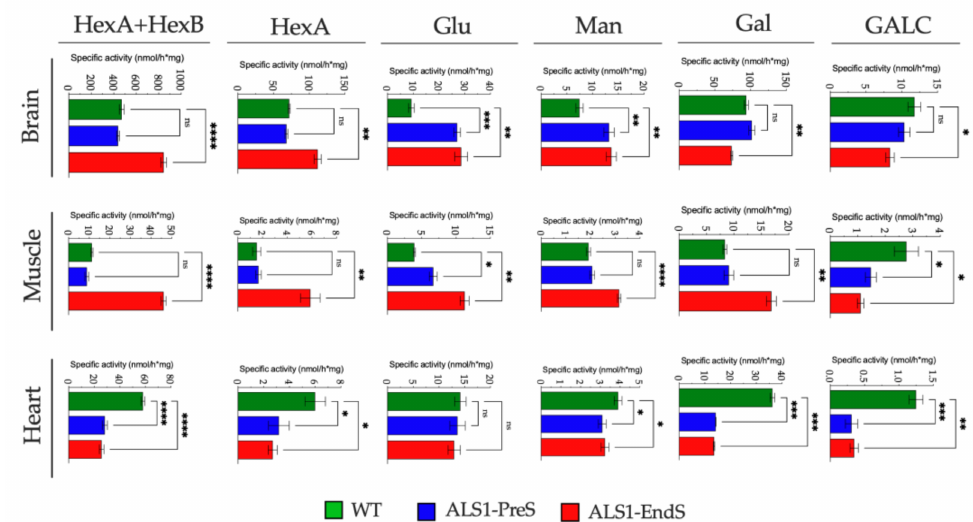
Figure 4. Activity of lysosomal glycohydrolases in tissues from ALS1 and WT rats. Levels of enzymes were measured by using specific fluorogenic substrates (see Section 2.14 for details). Results were expressed as the mean ± SD of three independent experiments, each in triplicates. * p < 0.05, ** p < 0.01, *** p < 0.001, **** p < 0.0001.